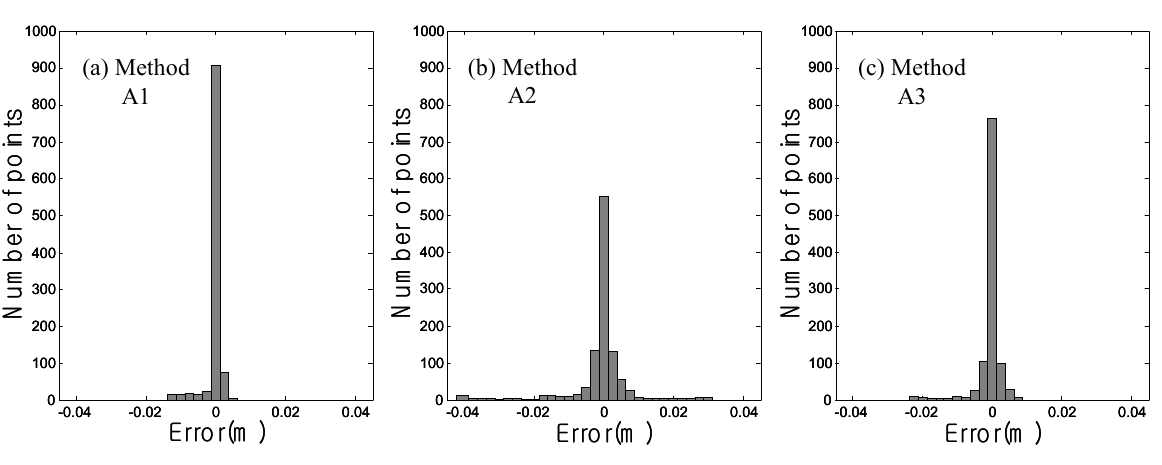
Figure 12. Histogram of the displacement measurement errors using the acceleration data processing